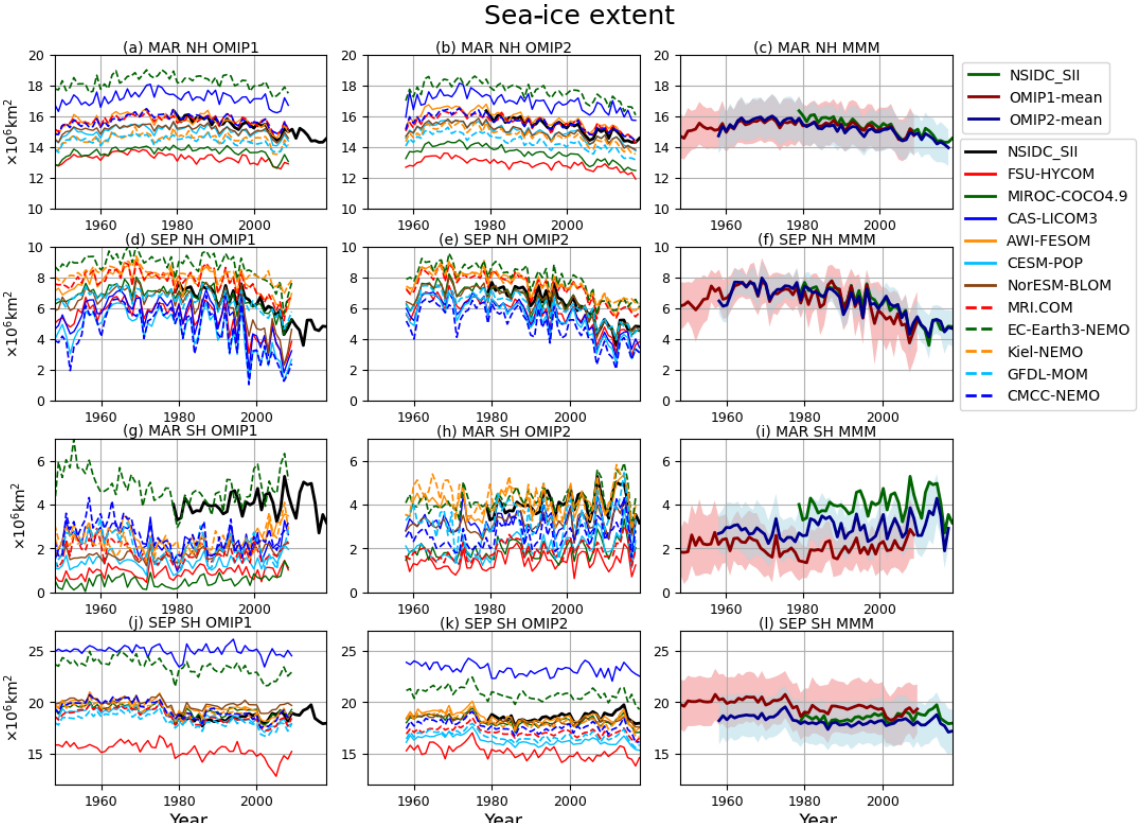
Figure 22. Time series of sea-ice extent in both hemispheres of the last cycle of the simulations (10 6 km 2 ). (a–c) March (winter) sea-ice extent in the Northern Hemisphere. (d–f) September (summer) sea-ice extent in the Northern Hemisphere. (g–i) March (summer) sea-ice extent in the Southern Hemisphere. (j–l) September (winter) sea-ice extent in the Southern Hemisphere. (a, d, g, j) OMIP-1, (b, e, h, k) OMIP-2, (c, f, i, l) multi-model mean (lines) and spread defined as 1 standard deviation (shades) of OMIP-1 (red) and OMIP-2 (blue). In each panel, National Snow and Ice Data Center Sea Ice Index (NSIDC-SII; Fetterer et al., 2017) has been depicted as a reference with bold black lines for the left and middle panels and bold green lines for the right panels. The model spreads ( ± 2 σ ) of both OMIP-1 and OMIP-2 capture the observation except for summer in the Southern Hemisphere of the OMIP-1 simulations (55% of the period from 1979 to 2009). See Table 2 for the z scores of the difference between OMIP-1 and OMIP-2 for the period from 1980 to 2009.